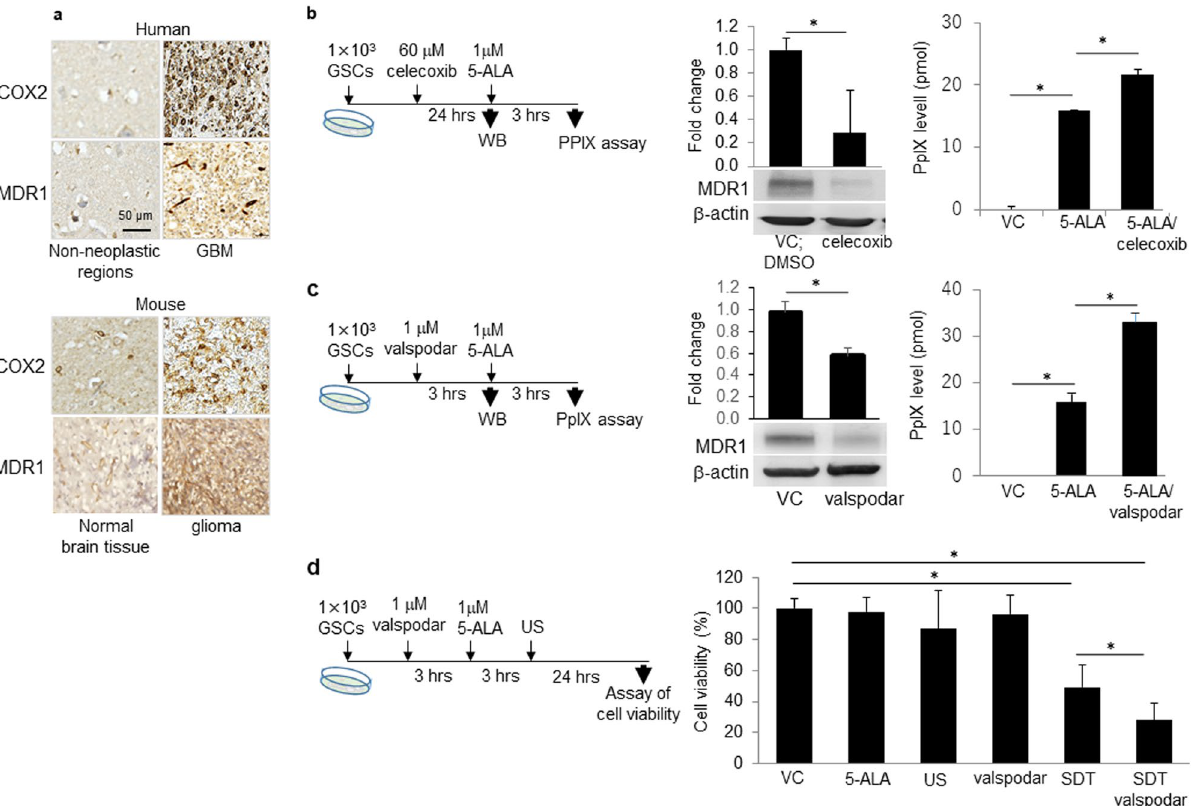
Figure 3. Elevation of PpXI through down-regulation of MDR1 leading to low cell viability in GSCs. ( a ) Representative expression of COX-2 and MDR1 by DAB stain in human GBM and GSCs-bearing mouse glioma model and each normal tissue. ( b ) Changes in MDR1 expression and PpIX level treated with celecoxib and 5-ALA. Western blot analysis performed at 24 h after treatment with 60 μM celecoxib and compared with DMSO as a vehicle control (VC). PpXI levels were determined at 3 h after 1 μM 5-ALA. Each column indicates mean ± SD values (n = 4). ( c ) Changes in MDR expression and PpIX levels upon treatment with valspodar as a MDR1 inhibitor and 5-ALA. Western blot analysis performed at 3 h after valspodar and PpXI level determined at 3 h after 5-ALA. ( d ) Cell viability of GSCs treated with 1 μM 5-ALA at 3 h after treatment with 1 μM valspodar. US was performed at 3 h after 5-ALA. Each column indicates mean ± SD values (n = 8). * p < 0.05 by Student’s t-test versus VC (2 groups) or Turkey–Kramer’s test versus others (> 3